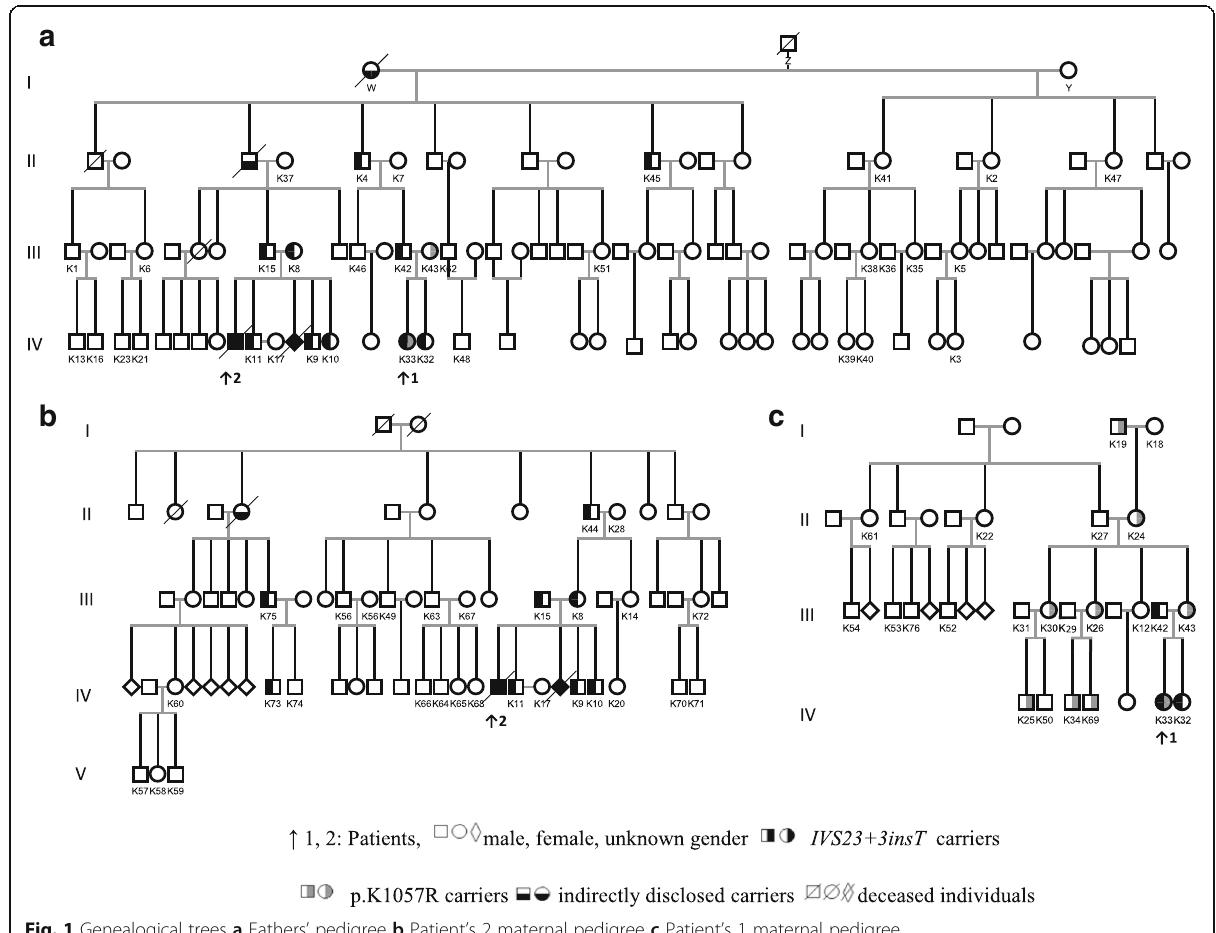
Fig. 1 Genealogical trees a Fathers ’ pedigree b Patient ’ s 2 maternal pedigree c Patient ’ s 1 maternal